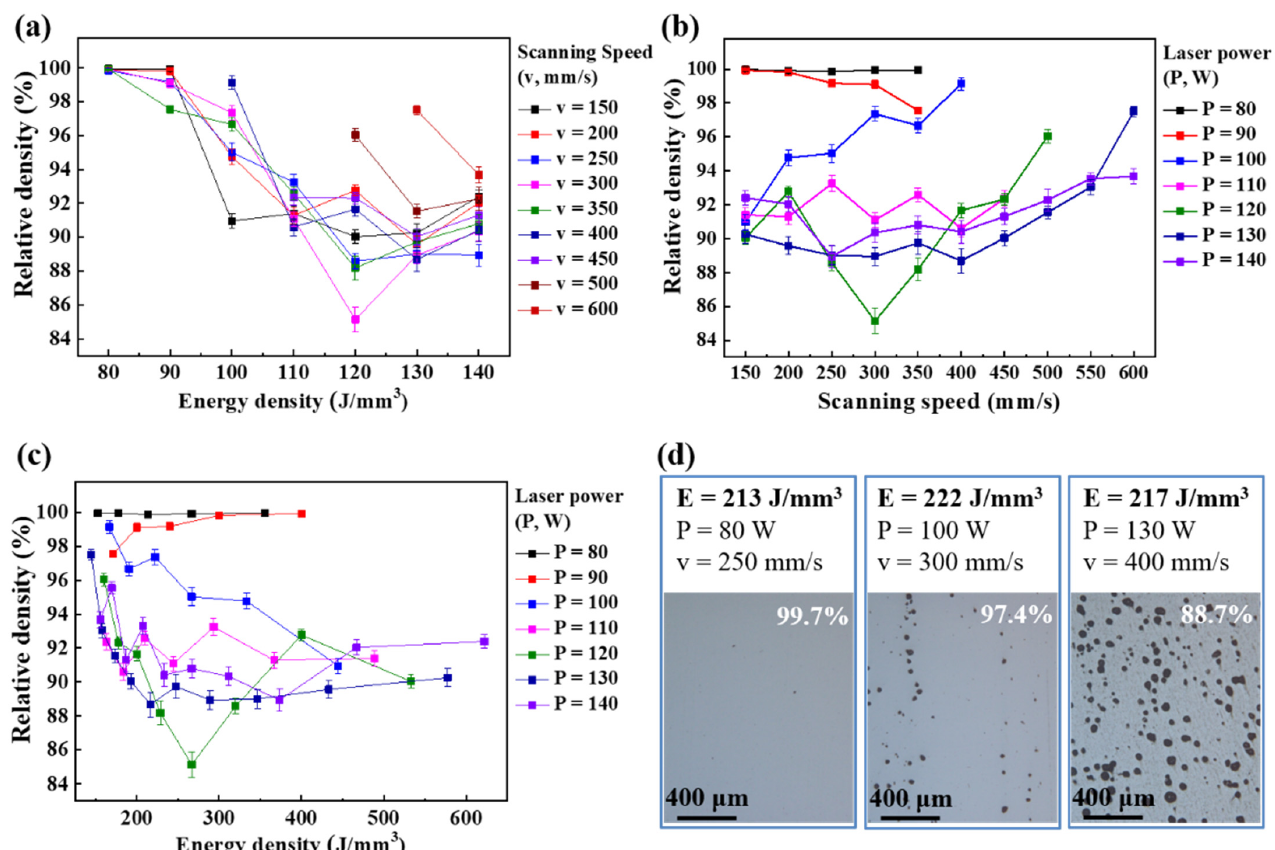
Figure 3. The relative density is a function with ( a ) laser power; ( b ) scanning speed; and ( c ) energy density. ( d ) Optical micrographs of the samples were fabricated under similar energy density but different P and v combinations.